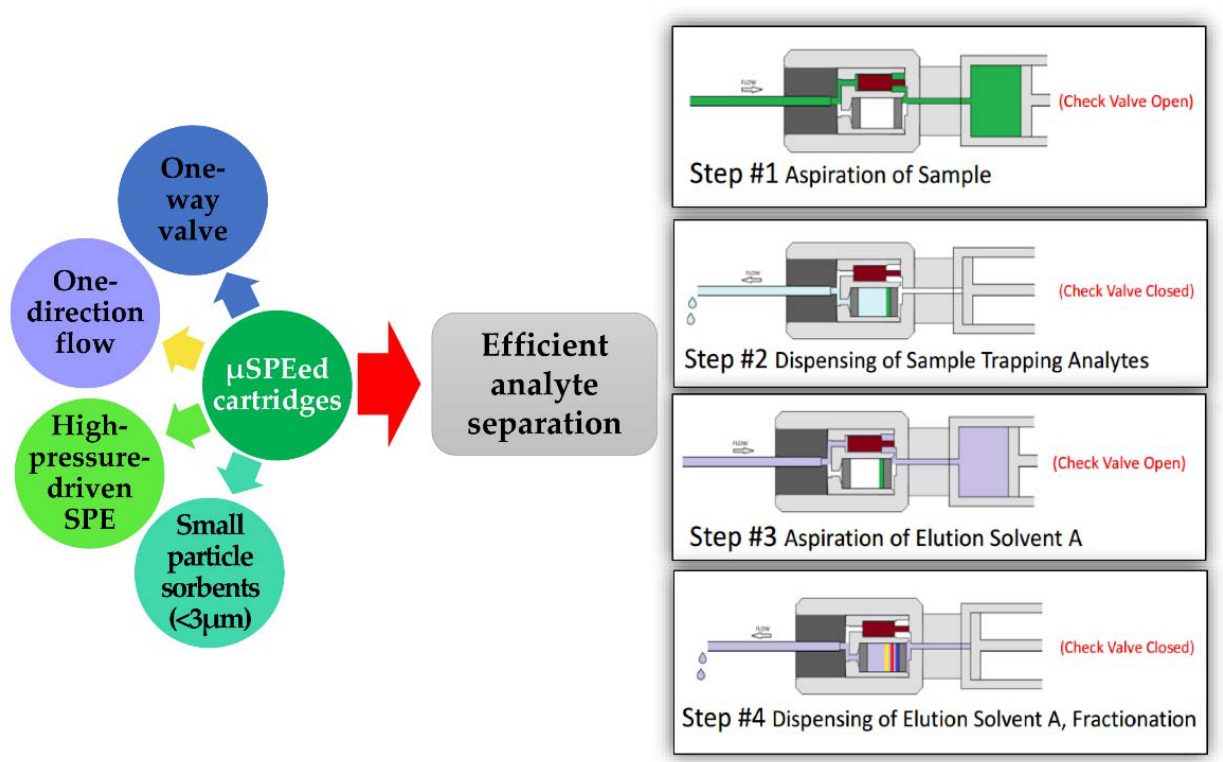
Figure 3. Advantages and schematic overview of μ SPEed.